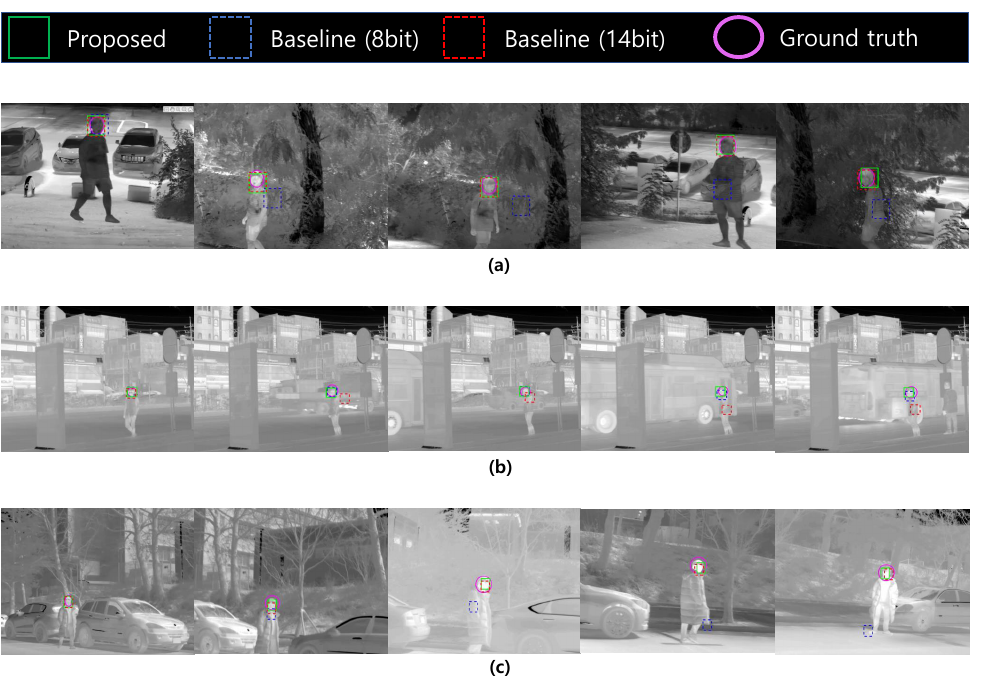
Figure 10. Video frame images of the track results were extracted using the method of the top performance using the brightness, 14-bit digital count and temperature for each sequence.